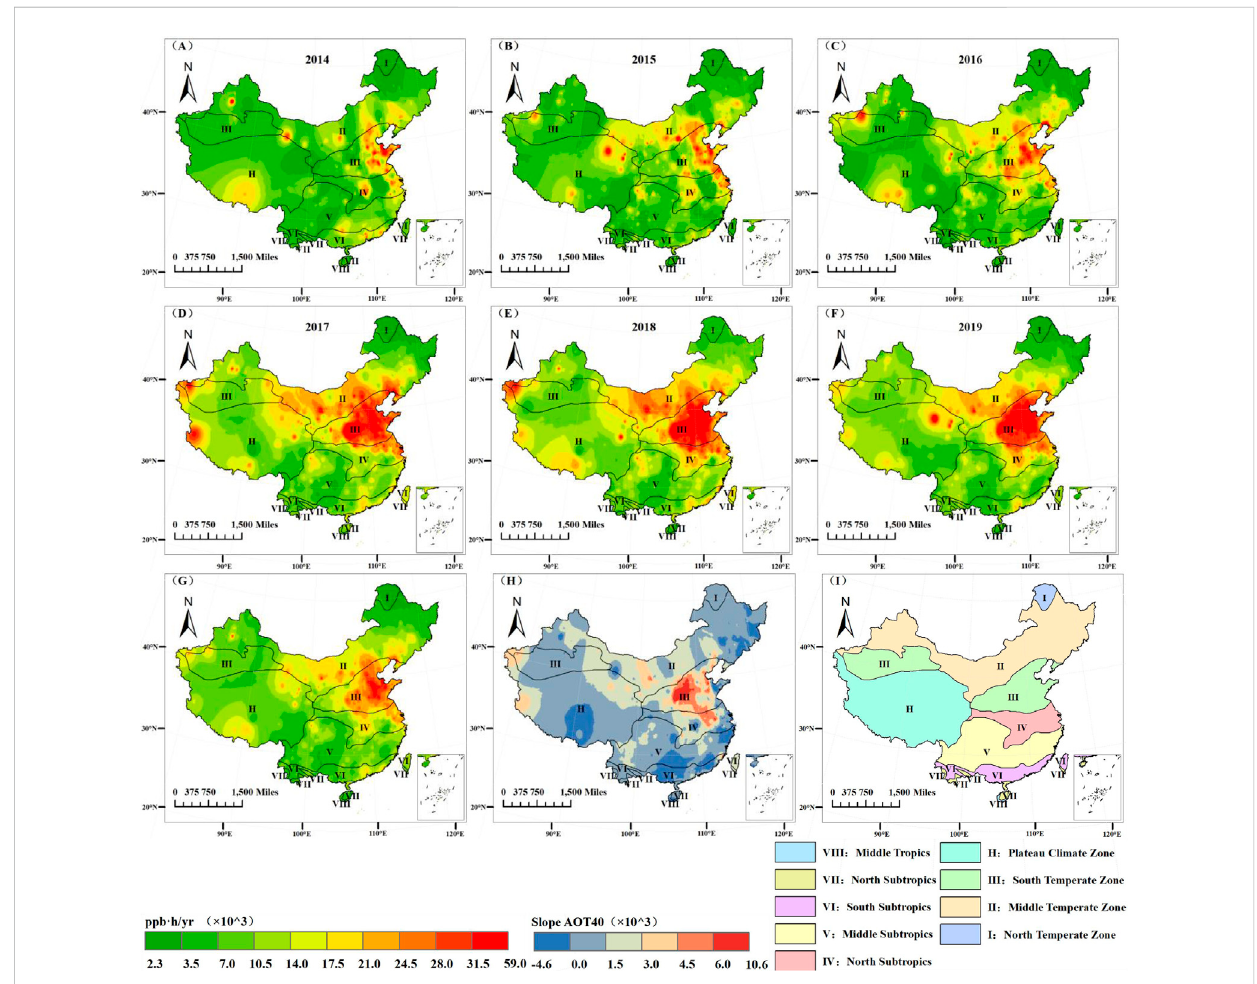
sample data A, the scatter plot is drawn, the Y -axis is set as the annual NPP value, and the X -axis is adjusted to the annual average of AOT40 of 6 years to reduce the in fl uence of AOT40 interannual variation, and the average is divided into 10 intervals. The average value of the annual NPP value in each interval is calculated to represent the overall data characteristics of the top point NPP in the AOT40 interval, and the midpoint value of the AOT40 interval is taken as the X value to draw 10 scatter points. Mann-Kendall mutation test method was used to test the signal mutation point. This method has no requirement for the distribution of samples and is less disturbed by a few outliers, so the results are